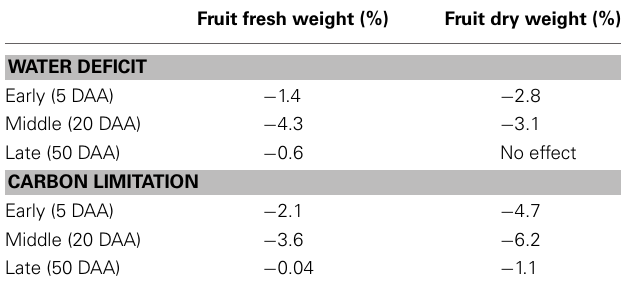
Table 2 | Predicted effect on fruit final fresh and dry weight after the application of a short (24h) stress treatment, with respect to control.